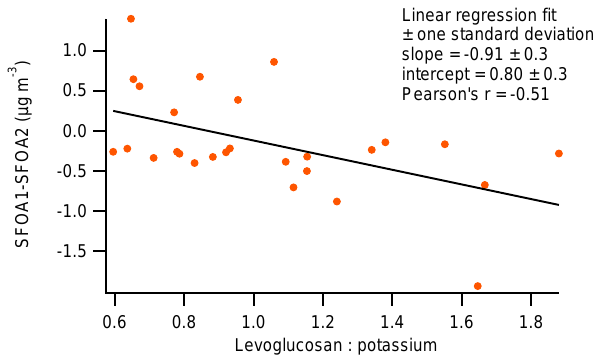
Figure 6. Variation of the difference between SFOA1 and SFOA2 concentrations with the levoglucosan : potassium ratio as derived from 24h filter